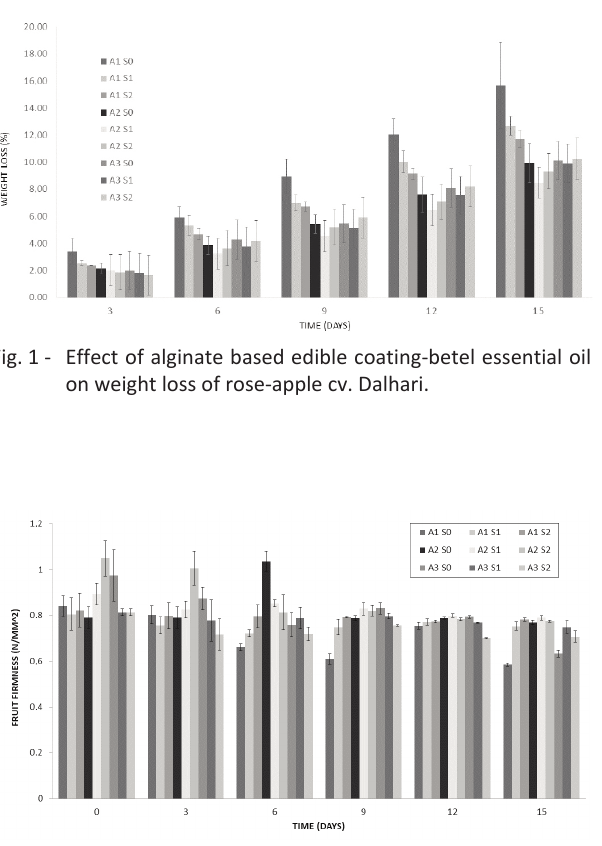
Fig. 2 - Effect of alginate based edible coating-betel essential oil on fruit firmness of rose-apple cv.